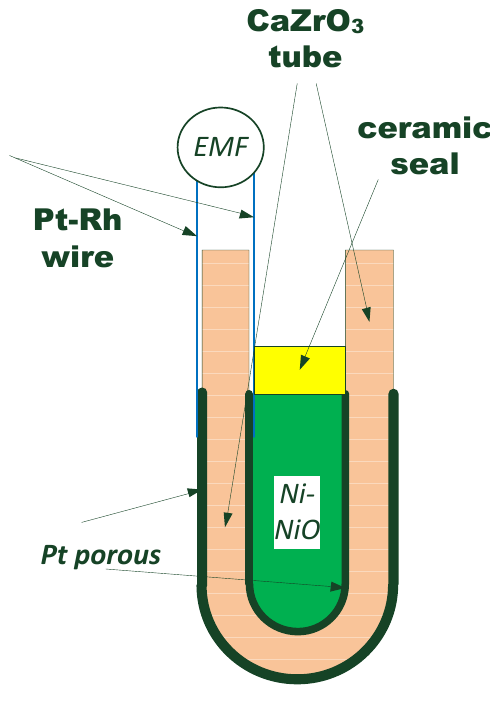
Figure 1. Scheme of electrochemical non-stoichiometric CaZrO involving a 51% mol CaO oxygen probe for molten Cu-based